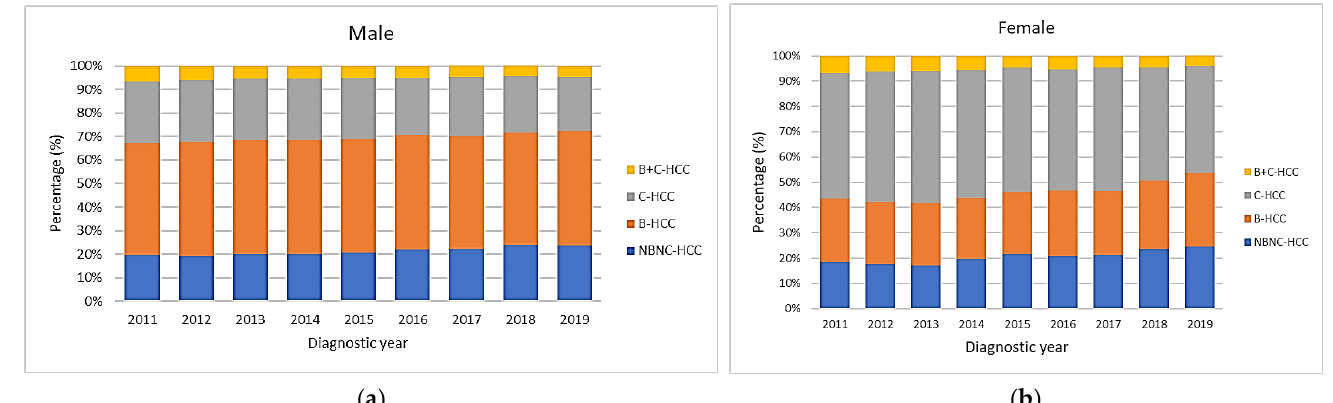
Figure 3. Secular trends of viral etiologies according to gender. ( a ) In male gender, HBV accounts for half of the cases. The proportion of NBNC-HCC increased over time, while the proportion of C-HCC decreased (all p values for linear trend <0.001). ( b ) In female gender, HCV accounts for nearly half of HCC cases. The proportions of B-HCC and NBNC-HCC increased, while the proportion of C-HCC decreased over time (all p values for linear trend <0.001).